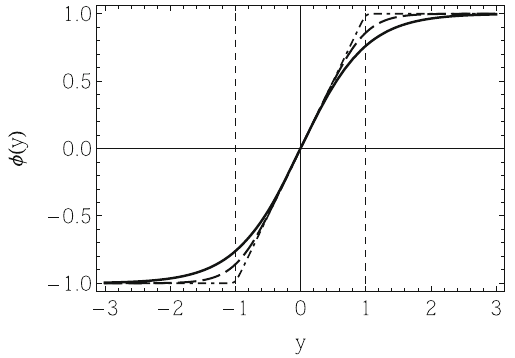
Fig. 4 Plot of field ϕ( y ) for a = 1, U 0 = 0, and ψ 0 = 1 with ϕ 0 = 1 . 4 (solid line), ϕ 0 = 1 . 55 (dashed line), and ϕ 0 = 1 . 7 (dotdashed line)